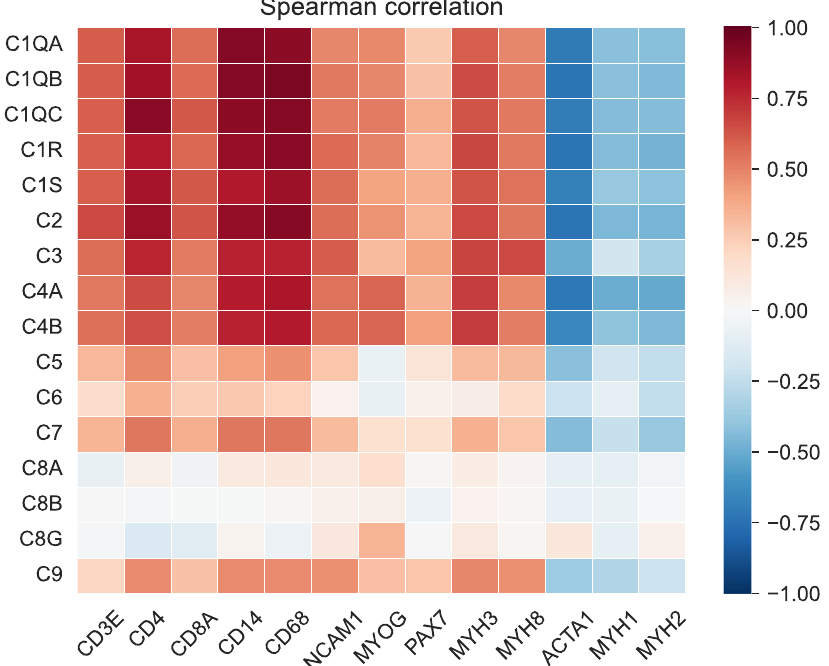
Figure 2. Correlation of complement expression with myositis disease activity. The analysis of bulk transcriptomic data showed that the local expression of complement was positively correlated with markers of muscle regeneration (NCAM1, MYOG, PAX7, MYH3, and MYH8) and canonical T-cell and monocyte/ macrophage markers (CD3E, CD4, CD8A, CD14, and CD68). In contrast, there was a negative correlation between the expression of complement proteins with markers of mature muscle cells markers (ACTA1, MYH1, and MYH2).